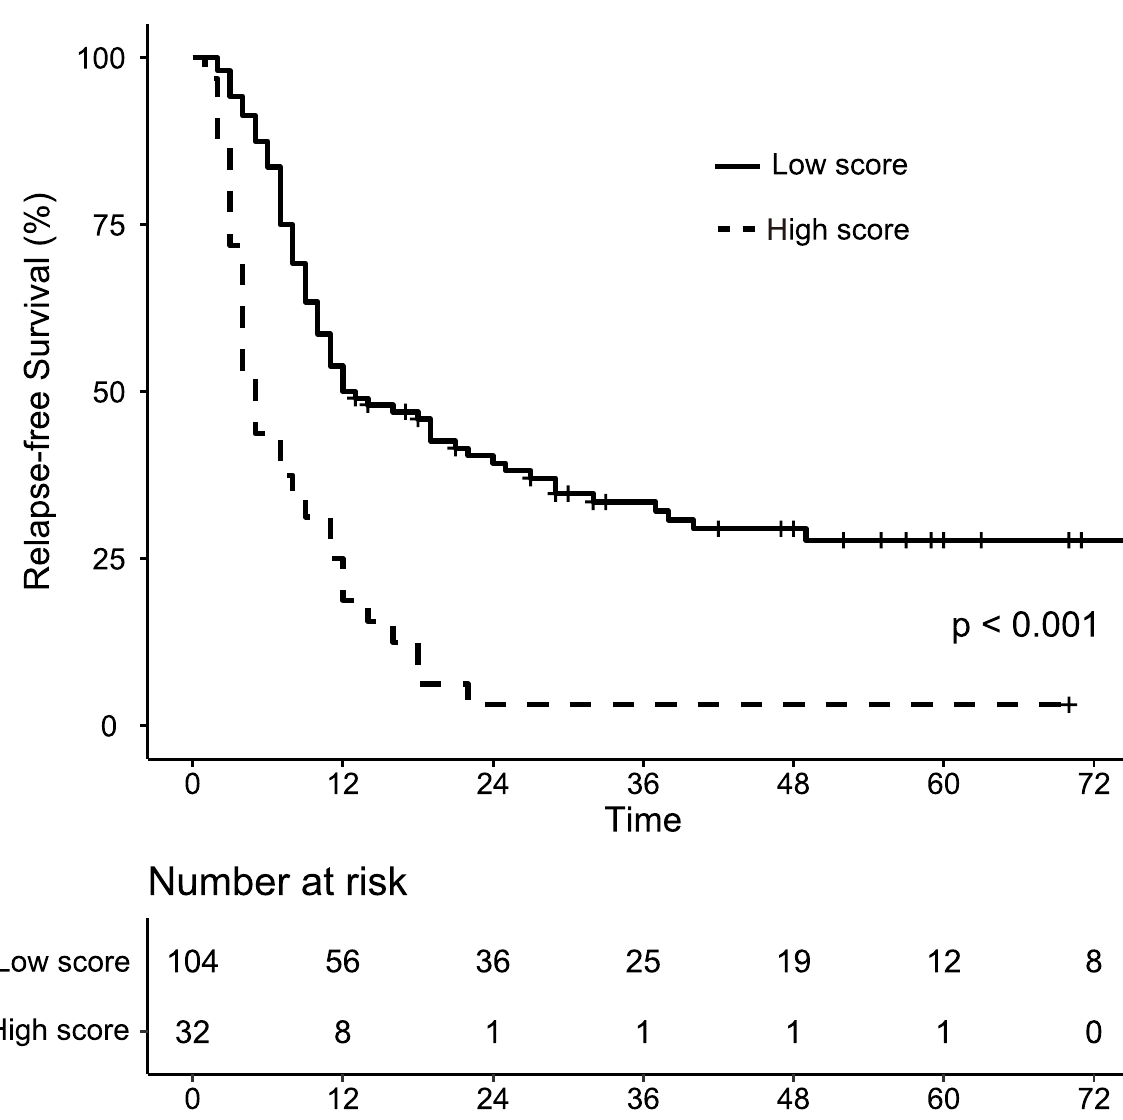
Fig 3. Kaplan-Meier analysis of relapse-free survival of patients with a high ( � -0.90) versus low ( < -0.90) Elastic Net model score in the whole cohort.